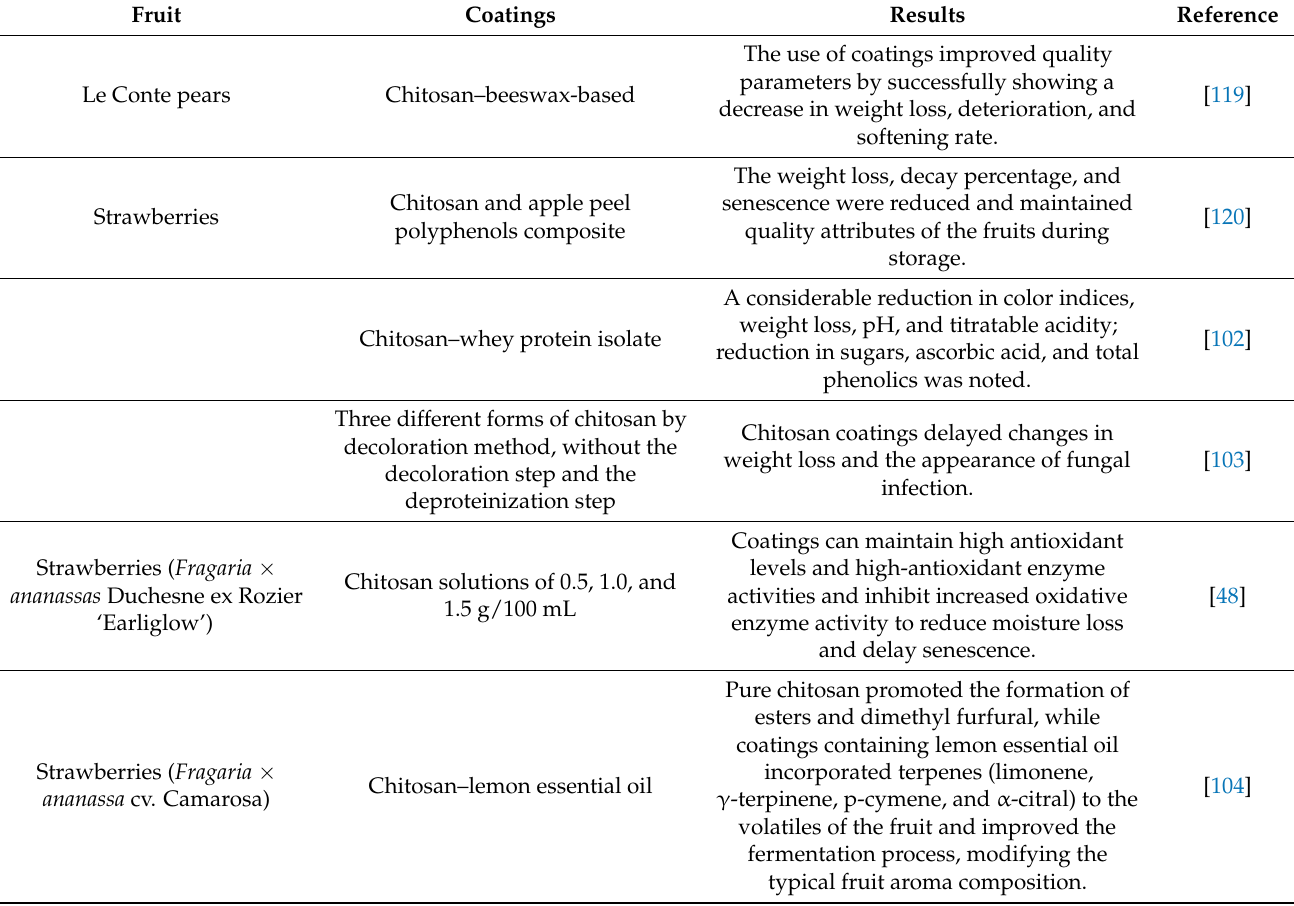
Table 5. Coating materials mixture with chitosan applied to extend the shelf-life and improve the quality of fruits. Fruit Coatings Results Reference